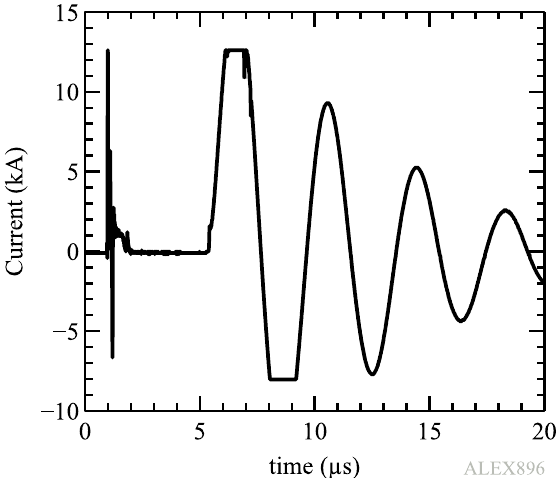
Figure 2. Current signal of an ALEX discharge through iron wire when the capacitors bank are nominally charged to 20 kV. Other experimental situations present similar shapes. Saturation of the signal is a side effect of the amplification necessary to measure the small signal of the dark pause, between 2 and 5 µ s in the present case, as further explained in the text.